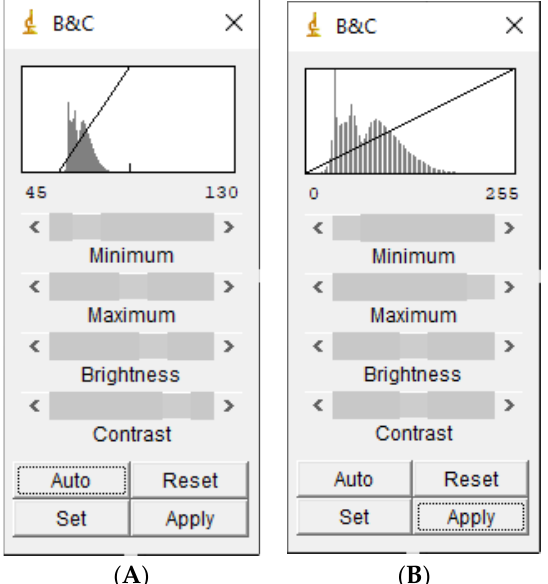
Figure 2. Change in the range of image brightness: ( A ) histogram before the change; ( B ) histogram after the change.